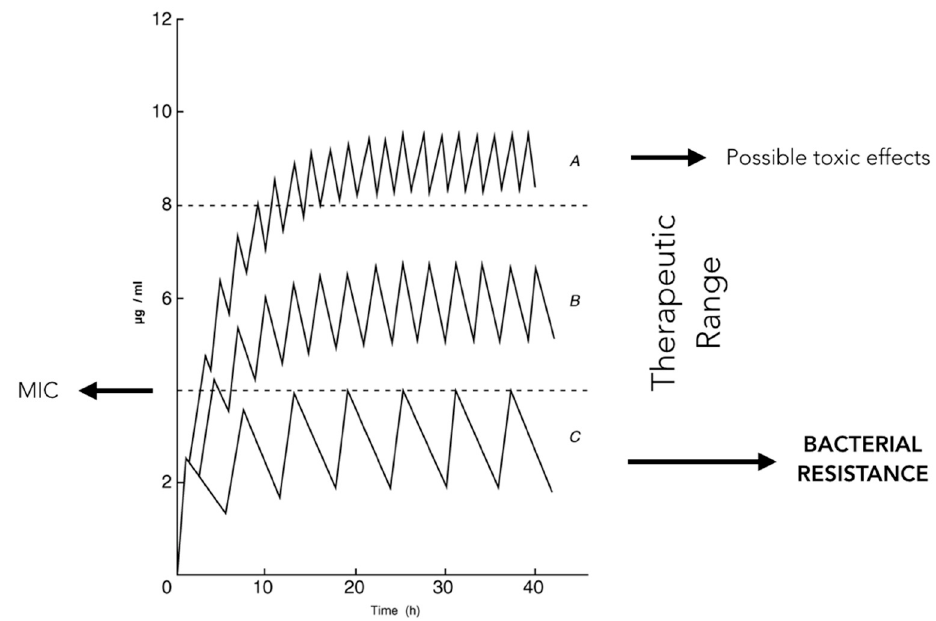
Figure 4. Figure showing how the modification of the interval of administration of a single dose can cause toxic effects or bacterial resistance.